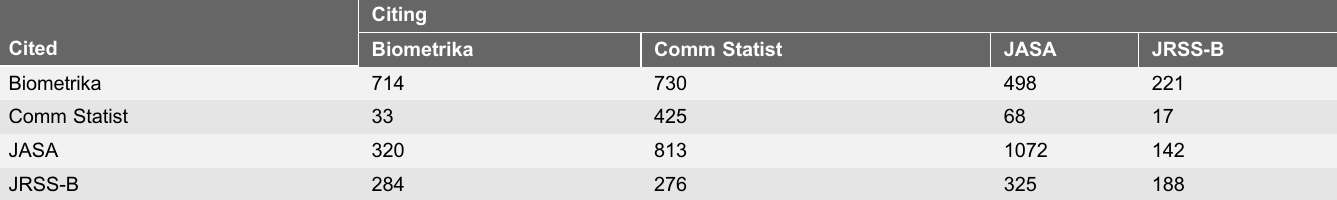
Table 1. Citation counts between journals. These counts are extracted from a larger table in Stigler